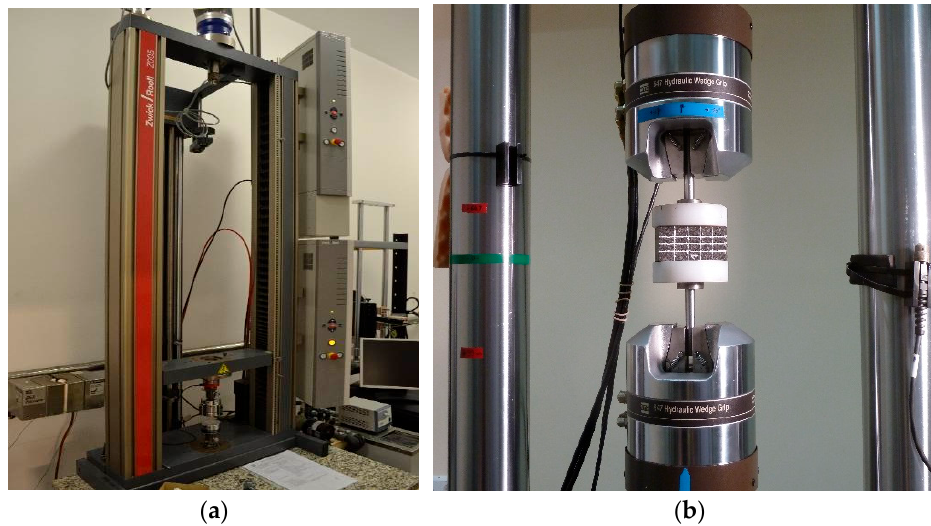
Table 1. Material properties of the specimens.